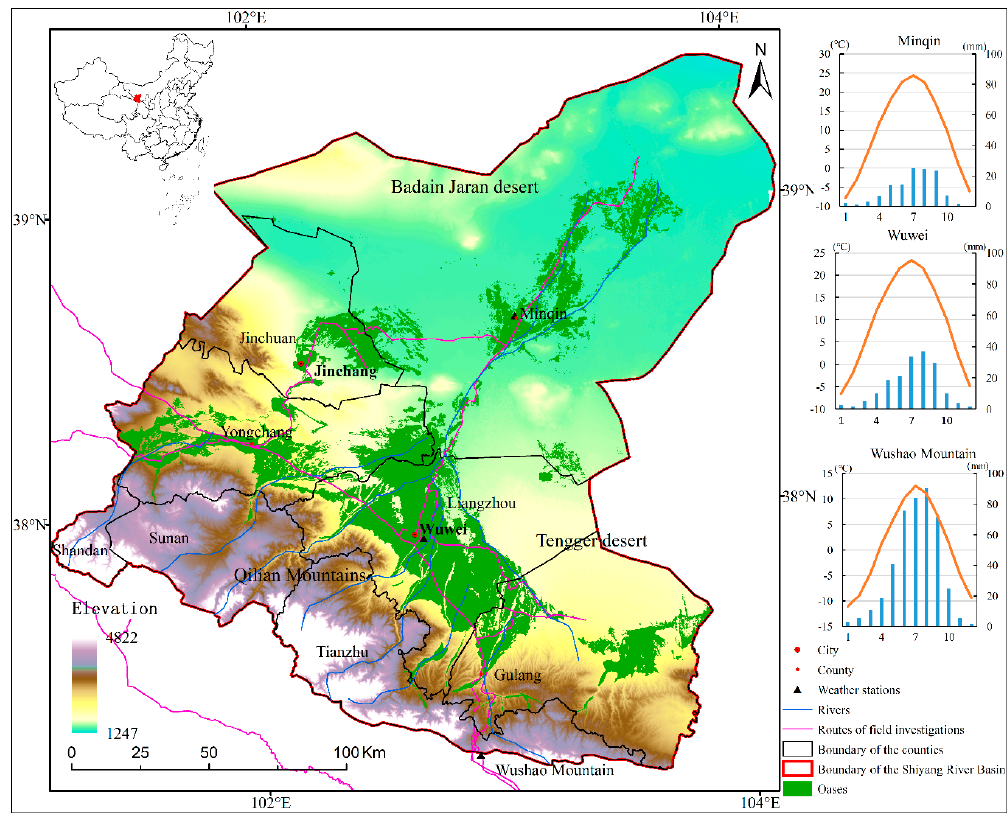
Figure 1. The study area in northwest China. The basin covers Wuwei Municipality, Jinchang Municipality and part areas in Zhangye Municipality, which contain eight counties: Liangzhou, Gulang, Tianzhu, Minqin, Yongchang, Jinchuan, Sunan, and Shandan. Black triangles are the locations of three weather stations that represent different climatic zones. The seasonal patterns of multi-years (2000–2017) averaged temperature and precipitation observed by the three weather stations are shown on the right [25].